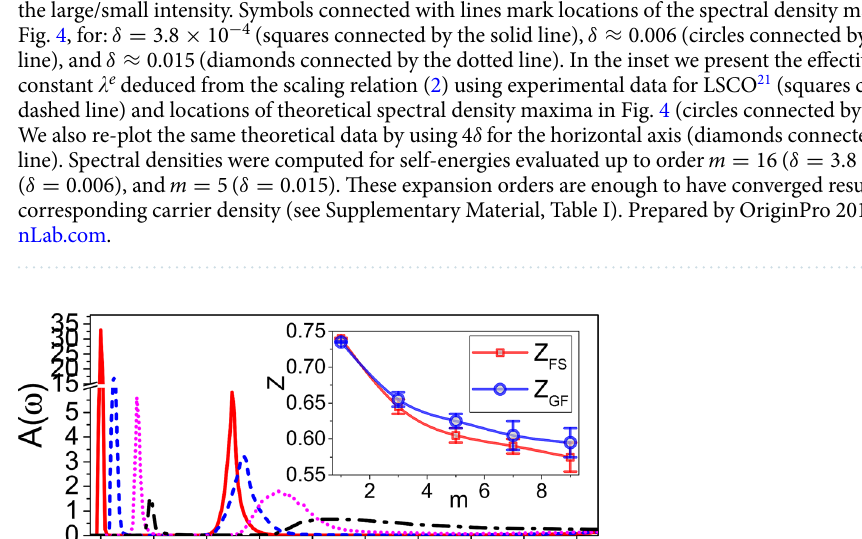
Figure 4. Spectral functions A (ω) at different momenta for δ (π/ 8, 0 ) (blue dashed line), q (red solid line), q = dash-dotted line). Energy zero was set at the value of the QP dispersion relation at q comparison between the two alternative procedures for computing the quasi-particle residue at q standard Fermi liquid relations at the Fermi surface, Z FS , and (ii) from the lowest-frequency peak in the spectral function, Z GF